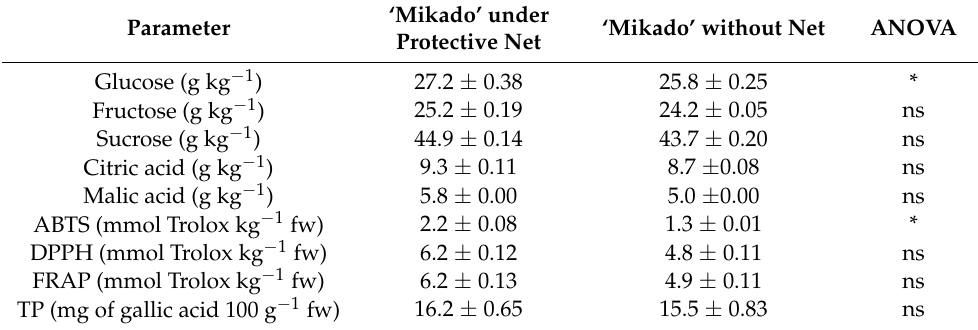
Table 3. Sugars and organic acids profile, antioxidant activity, and total polyphenols of ‘Mikado’ apricot grown under protected net and without net. Mean values ± standard deviation ( n =